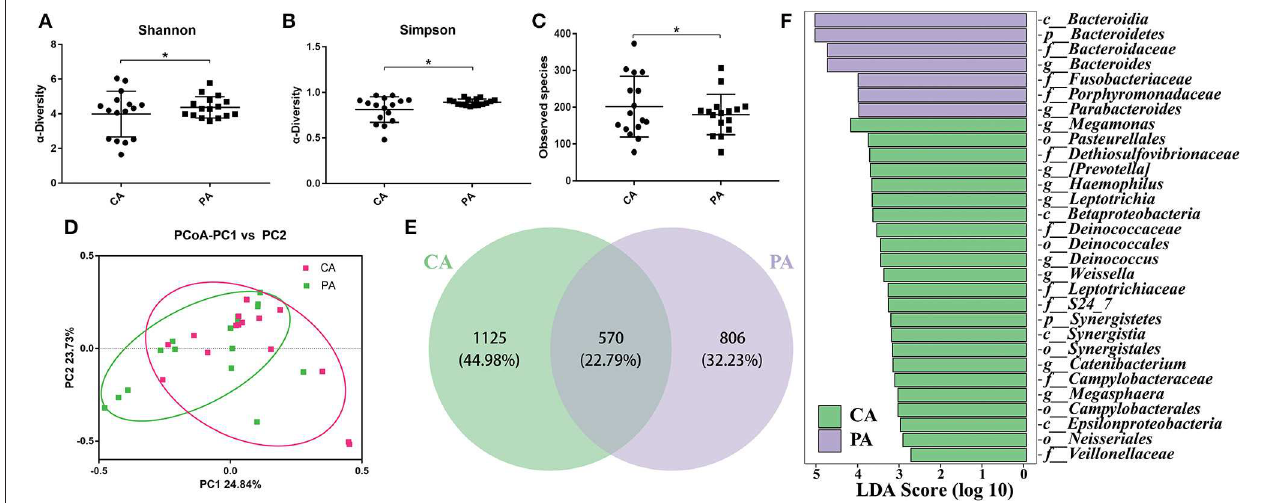
FIGURE 5 | The microbial changes between groups CA and PA. (A) , Shannon index; (B) , Simpson index; (C) , Observed species; (D) , PCoA of β diversity index; (E) , scalar-Venn representation; (F) , Lefse index. CA, control group 5–7 days after bowel preparation (n = 16); PA, probiotic group 5–7 days after bowel preparation (Supplement the Bifidobacterium Tetragenous viable Bacteria Tablets after colonoscopy for up to 5–7 days, three tablets and three times a day) ( n = 16). Data are presented as means ± SD. * P < 0.05.